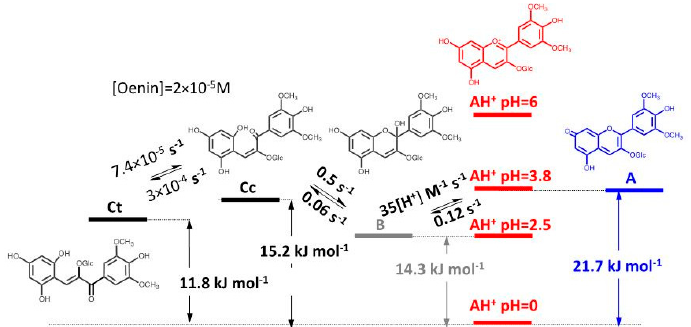
Scheme 2. Energy-level diagram for malvidin-3-glucoside (Oenin), obtained according to the procedure